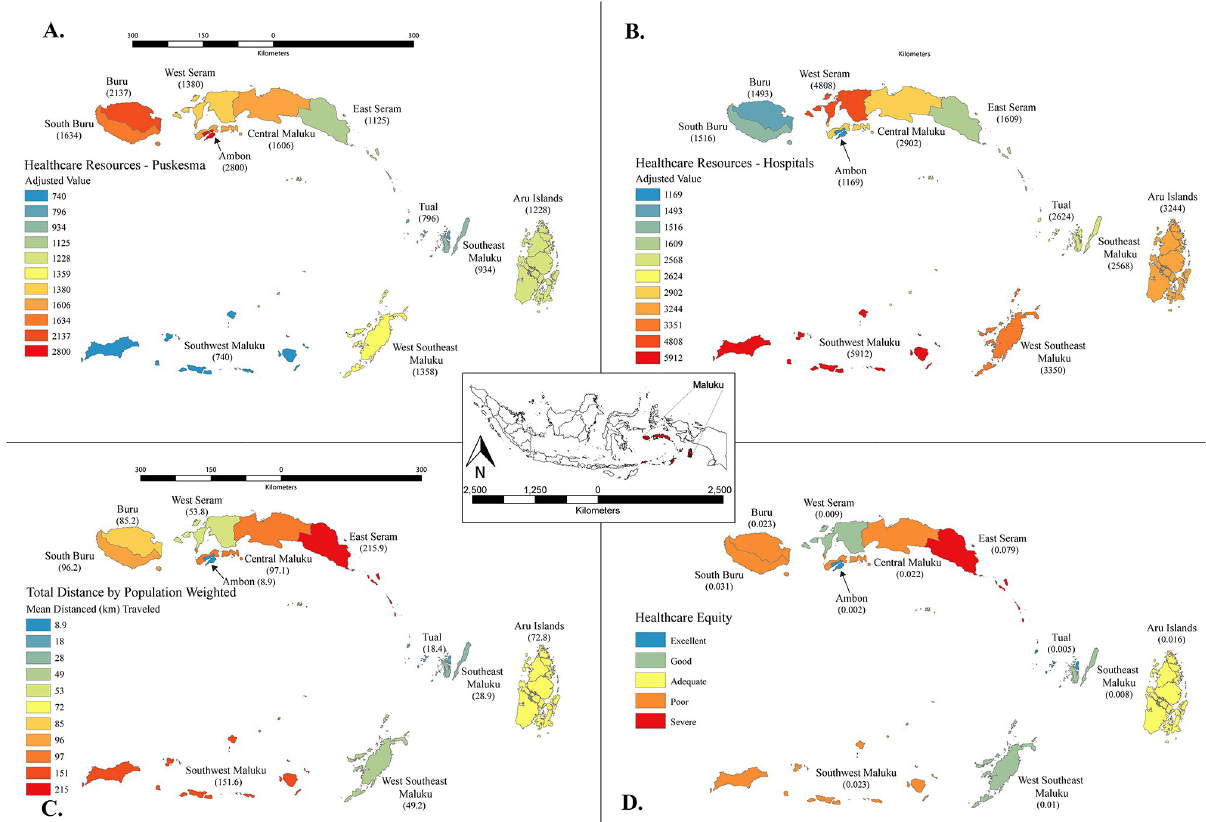
Fig 4. Key healthcare characteristics by district. Health workers in puskesmas (A) and hospitals (B) (weighted by type of health workers and their ratio to population), and total distance traveled to healthcare center (weighted by proportion of population with access by land only, and proportion of population that require access by land and naval routes) (C). Overall healthcare equity by district (D) provides a spectrum of values ranging from excellent (low values) to severe (high values), as a function of healthcare coverage weighted by provider availability and distance required to travel for care across Maluku Province, Indonesia. Base map provided by GADM https://gadm.org/maps/IDN.html. License https://gadm.org/license.html.